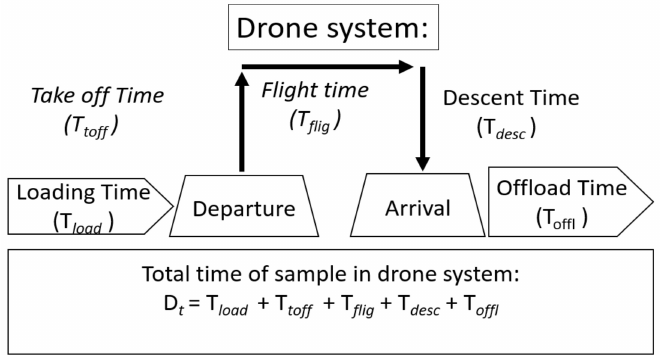
Figure 4. Model of the drone flight system and time